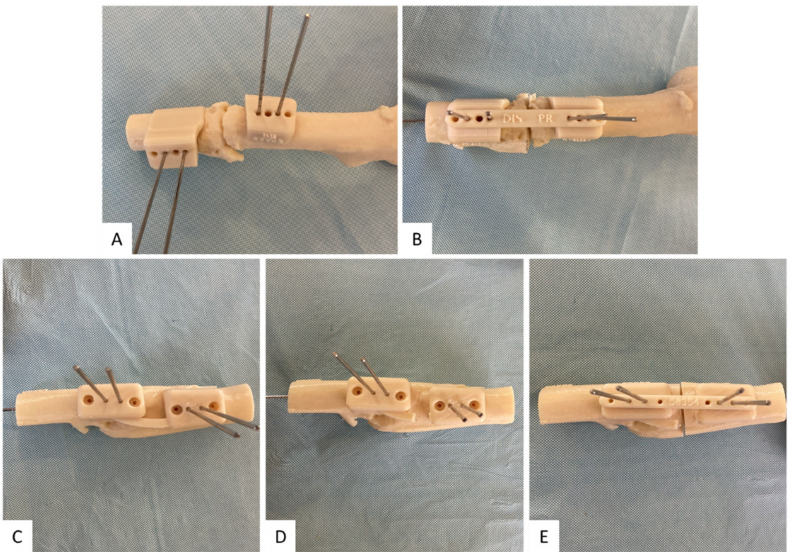
Figure 3. Surgical procedure. Guides are fixed separately in cases of fracture sequelae to correctly adapt them to the relief of the bone ( A ) and then the rotation is performed until the wires are aligned ( B ). In cases of idiopathic anteversion without fracture and in cases with poorly exuberant callus bone, the guide is first fixed with the pieces joined together ( C ), and then separated ( D ) and rotated until the alignment of the wires is achieved ( E ).